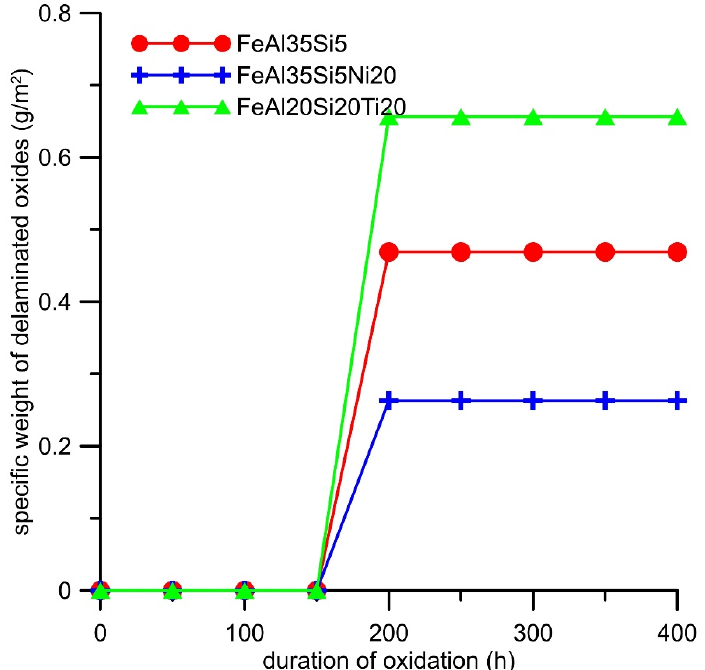
Figure 8. Dependence of the weight of delaminated oxides (g · m − 2 ) on the duration of cyclic oxidation at 800 °C in air.